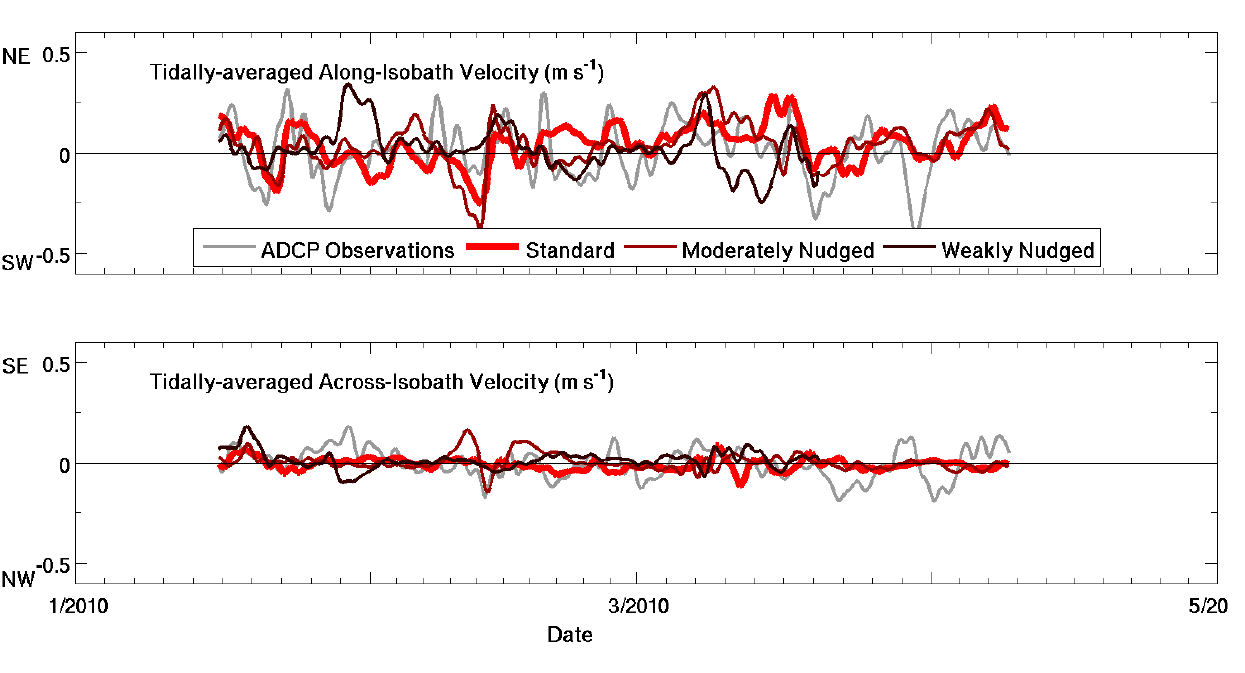
Figure 7. Time series of tidally- and depth-averaged water velocities from the Poverty Gap tripod in 40 m water depth. Observations (grey) and model estimates, including the standard model (thick red line), moderately-nudged (maroon), and weakly-nudged sensitivity tests